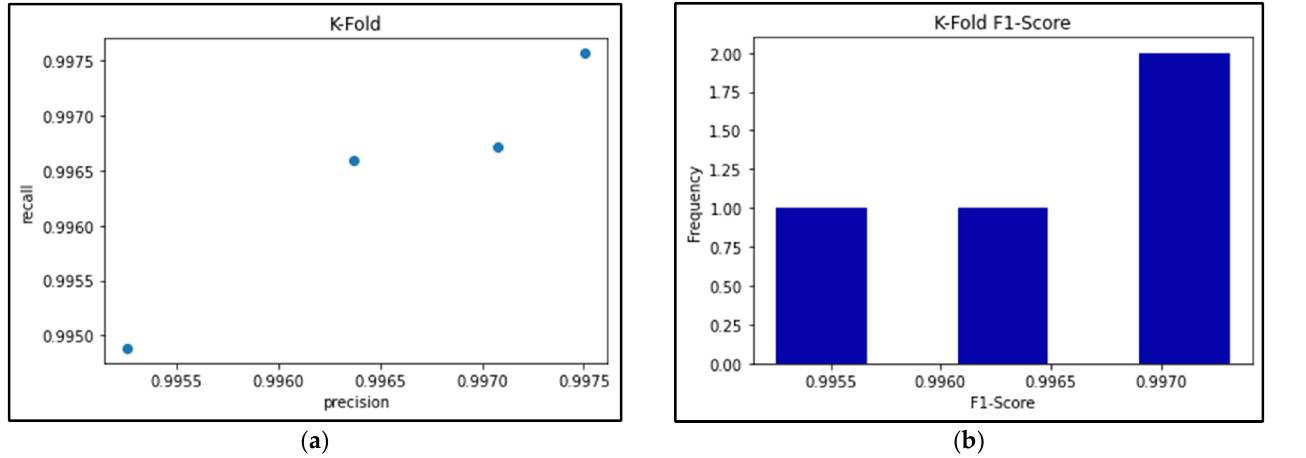
Figure 24. ( a ) Precision vs Recall graph of 4-fold EfficientNetB0 model; ( b ) Histogram of F1-scores for 4-fold EfficientNetB0 model. Table 7. EfficientNetB0 model: F1-scores per fold.